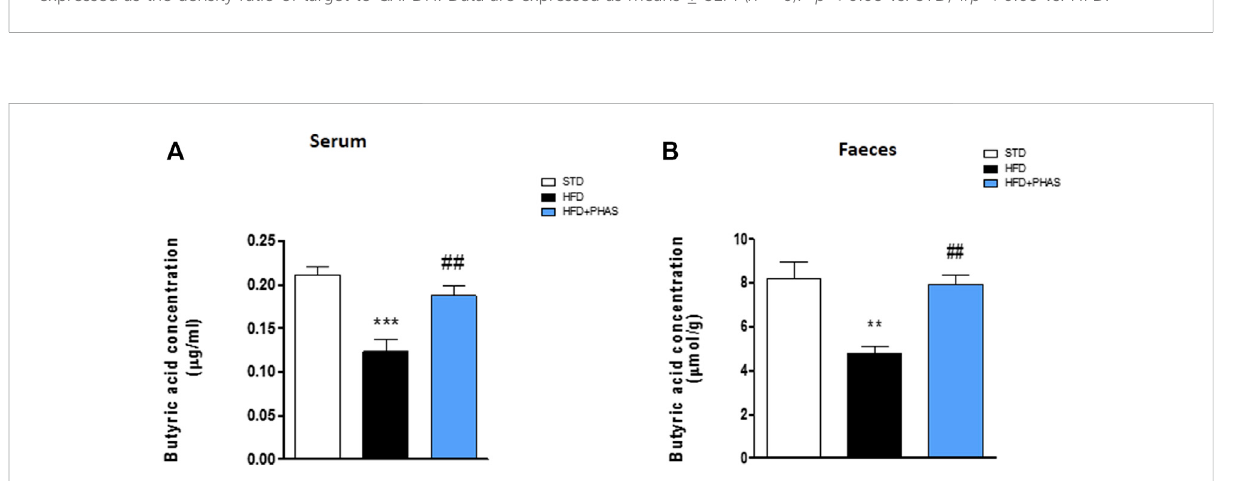
FIGURE 3 P. vulgaris extract effect on butyric acids levels in serum (A) and stools (B) both after 19 weeks from initiation of HFD diet, evaluated by GC-MS. Data are means ± SEM ( n = 6). ** p < 0.01 and *** p < 0.001 vs. STD; ## p < 0.01 vs.